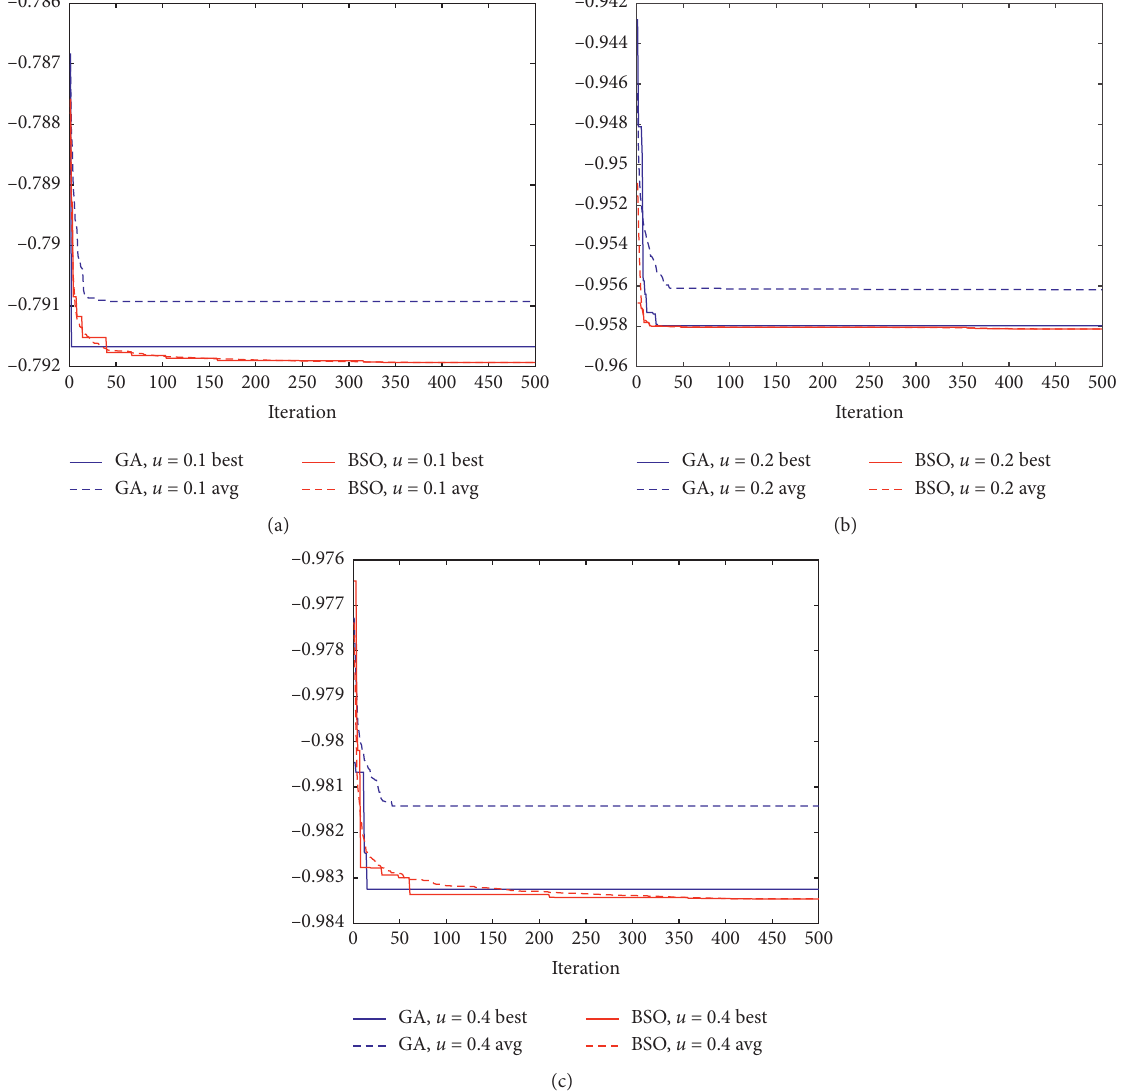
Table 3: Maximum solutions in BSO, u